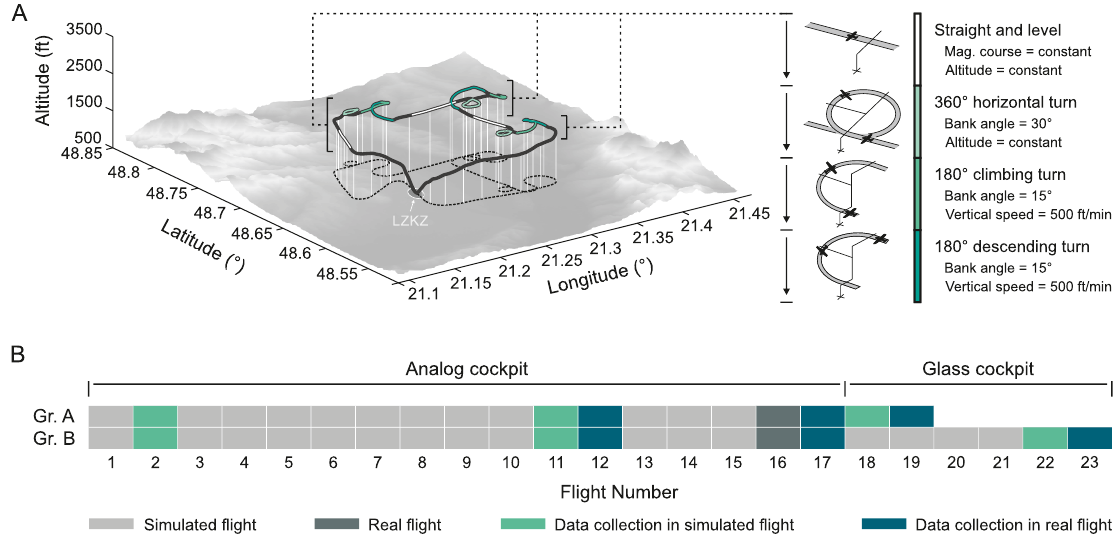
Figure 2. Example of flight pattern with marked prescribed manoeuvres ( A ) along with training schedule for Group A and B ( B